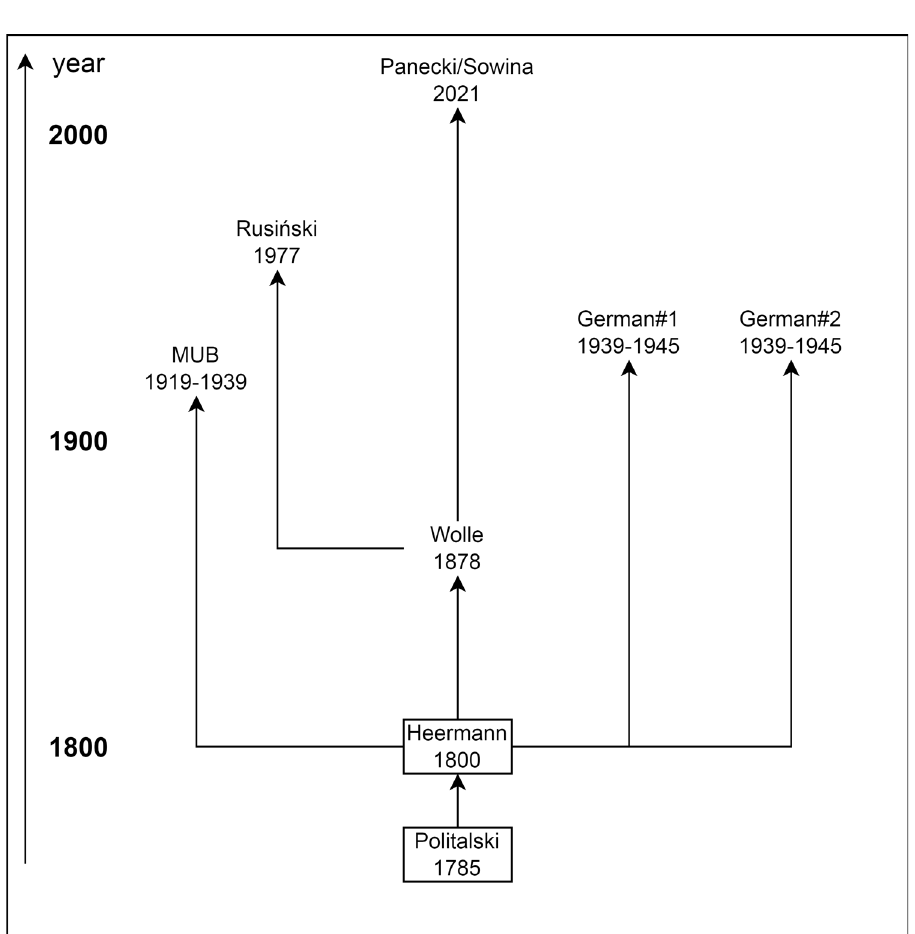
Fig. 4. Diagram depicting the provenance of Politalski map (1785) copies and version. Maps given in square are no longer existing. Source: own